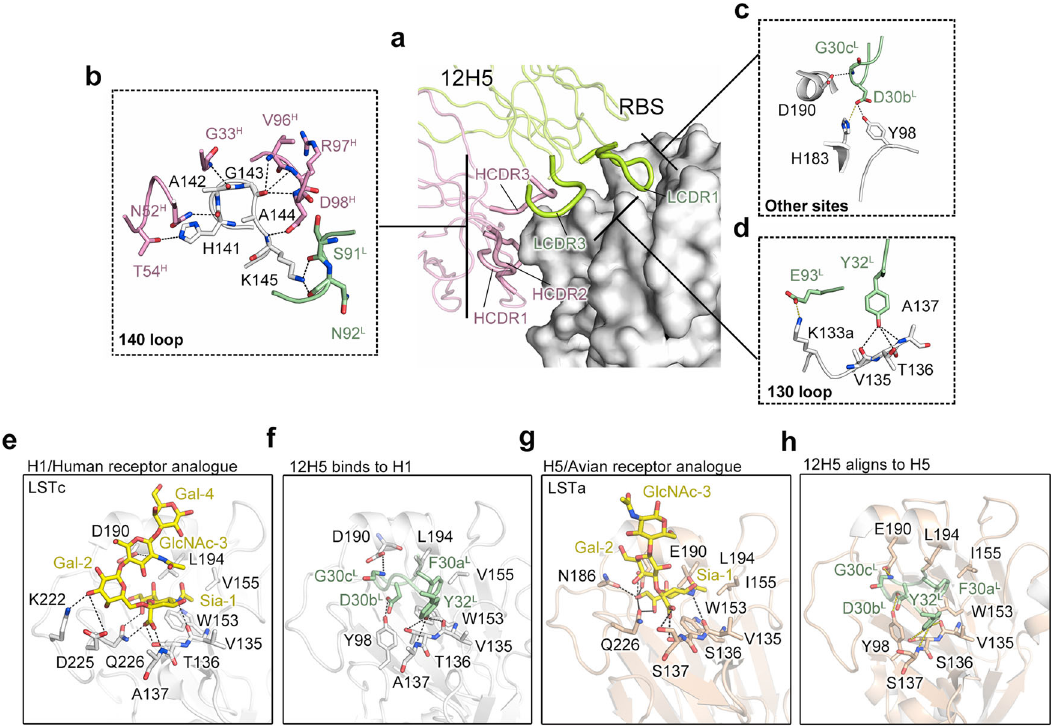
Fig. 6 | 12H5 mimics the receptor-binding mode of H1 and H5. a – d Hydrogen bondsandsaltbridgesbetween12H5and140-loop( b ),130-loop( d )andothersites (D190, H183 and Y98) ( c ). e – h Receptor mimicry of 12H5. e Hydrogen bond inter- actions between the receptor analog LSTc and the H1 RBS, as shown in the co- crystal structure (PDB code: 3UBE). The carbohydrate group of the LSTc Sia ter- minus stretches into a hydrophobic cavity enfolded by side chains of W153, L194, and V155. f Hydrogen bonding between the 12H5 LCDR1 tip and the V135-A137